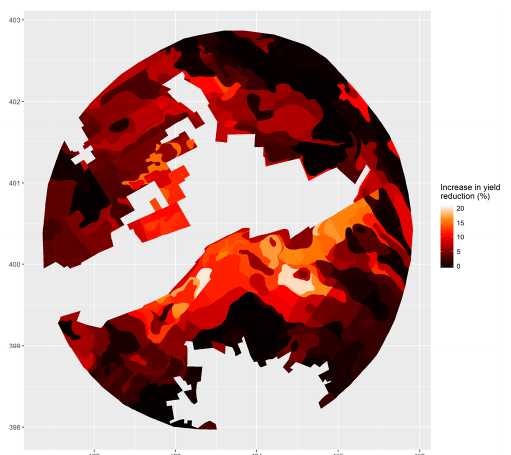
Figure 10. Application of the meta-model WaterVision Agricul- ture to the Vierlingsbeek area in the Netherlands. The effect on crop yield resulting from the lowering of the groundwater levels is shown as annual average increase in yield reduction compared to a situa- tion without changes in groundwater